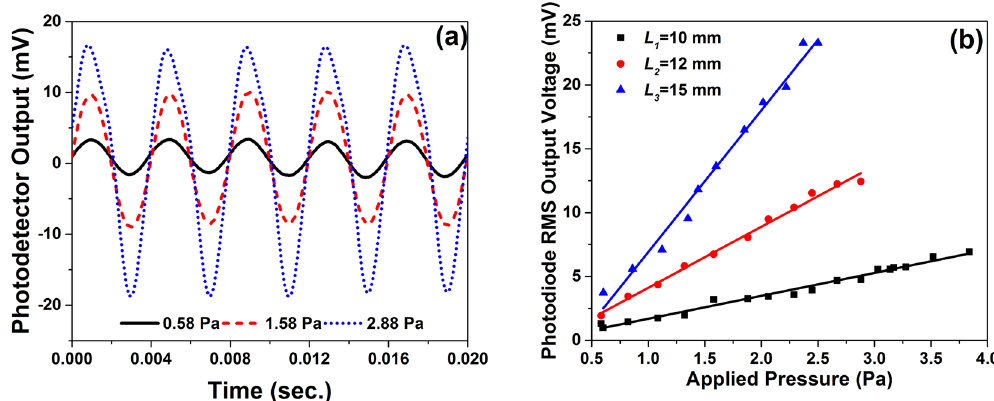
Figure 7. ( a ) Time domain response recorded for MCM with cantilever length 12 mm with different acoustic pressures at 250 Hz; and ( b ) Variation of photodiode RMS voltage ( V rms ) with different applied acoustic pressure at 250